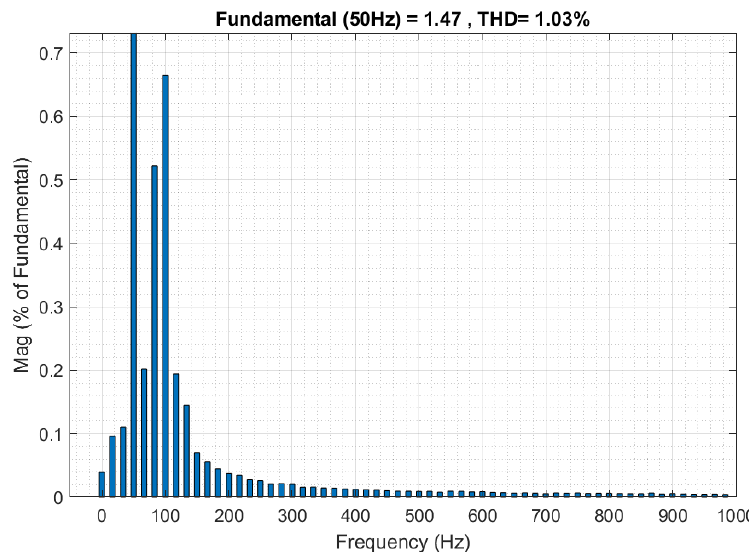
Figure 25. THD obtained for the AC load 1 current under OCF.